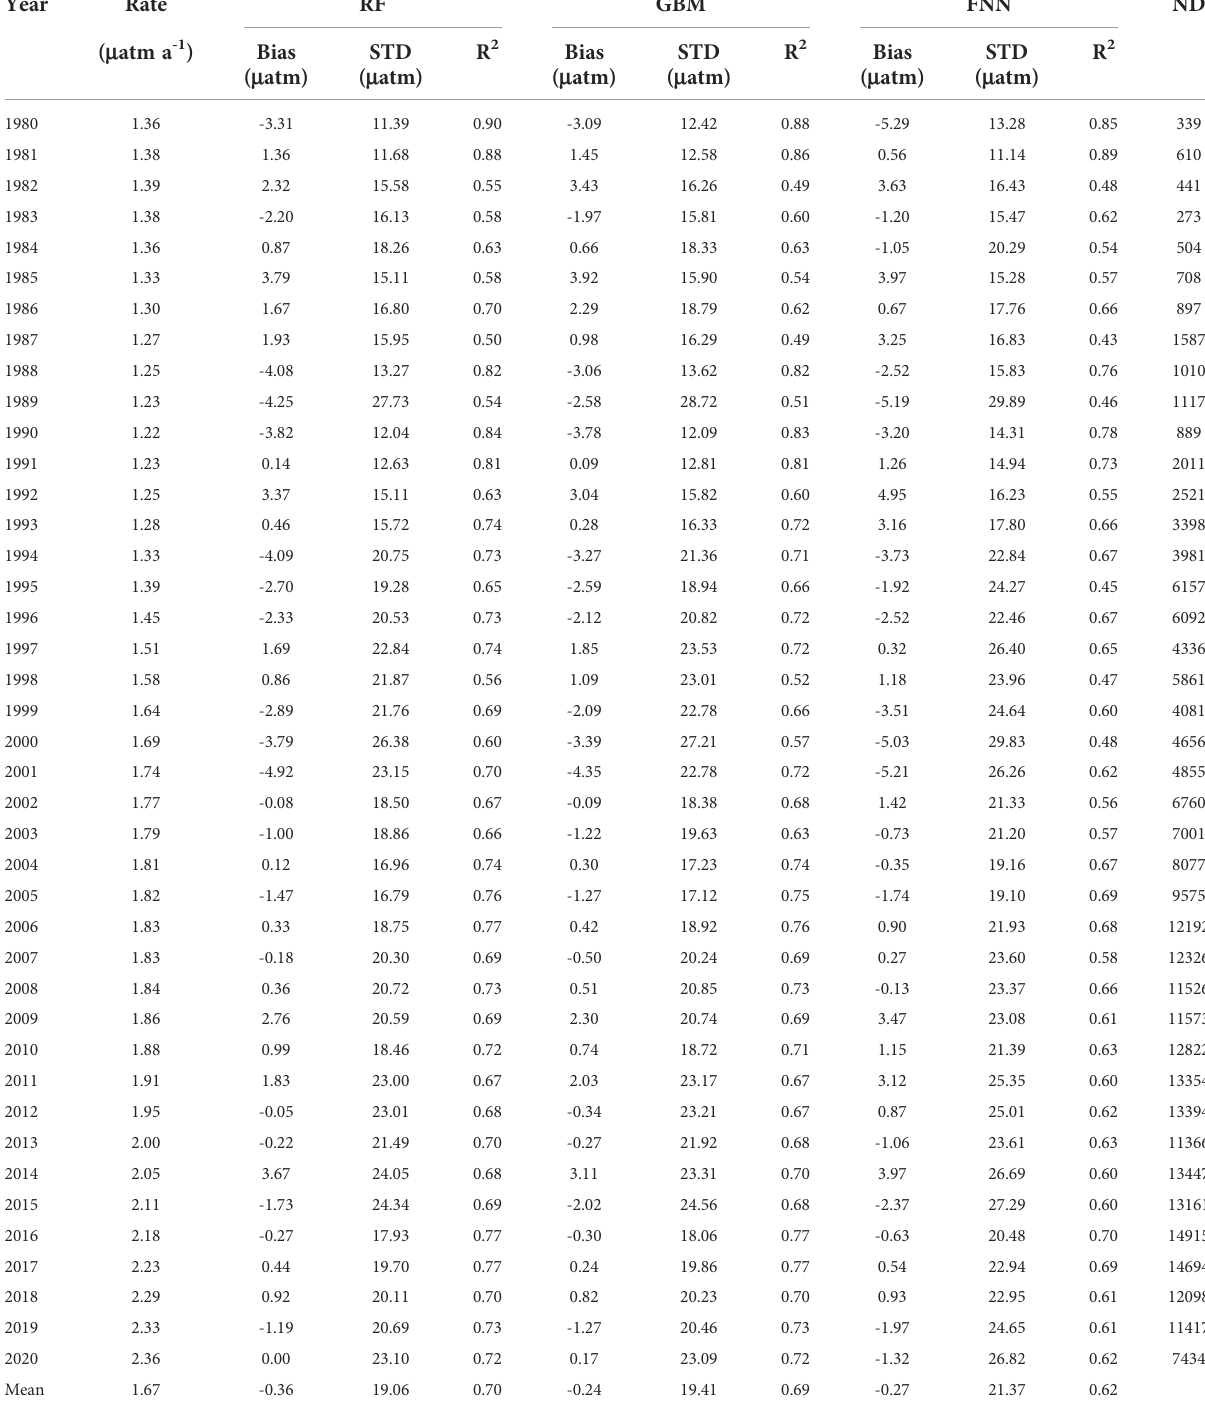
TABLE 3 Trends for data normalization and LOYO validation